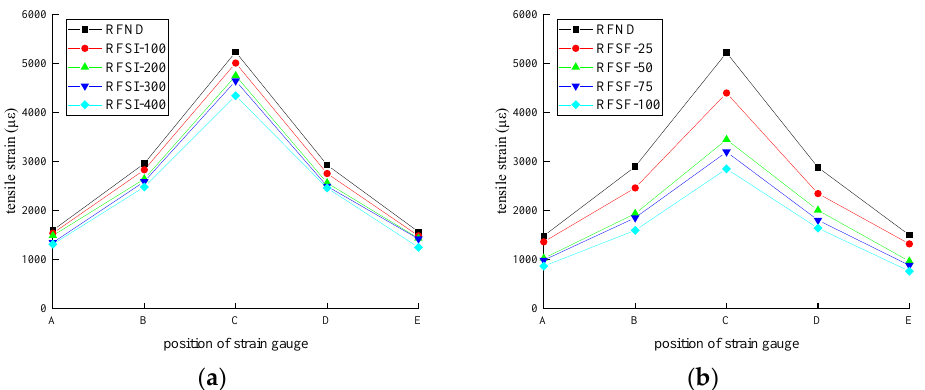
Figure 31. Strain of CFRP strip: ( a ) chlorine salt immersion environment and ( b ) salt-freeze coupled environment.